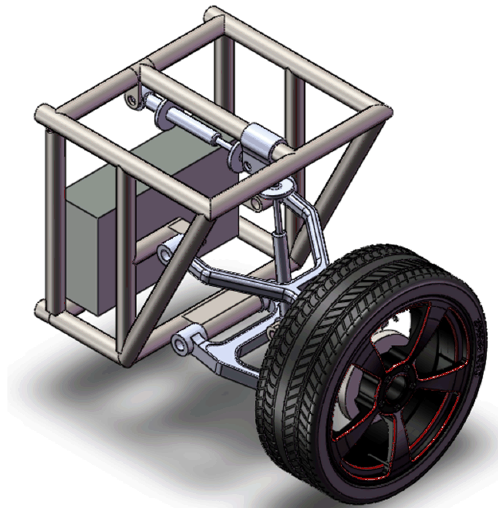
Figure 9. Solidworks Quarter Car Model.